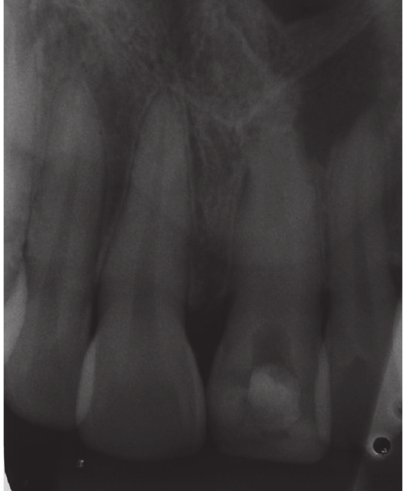
Figure 1: Initial radiograph of the maxillary right central incisor.